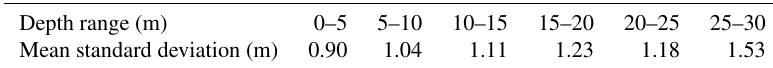
Table 3. Accuracy values were obtained using the source data metadata and specifications (International Hydrographic